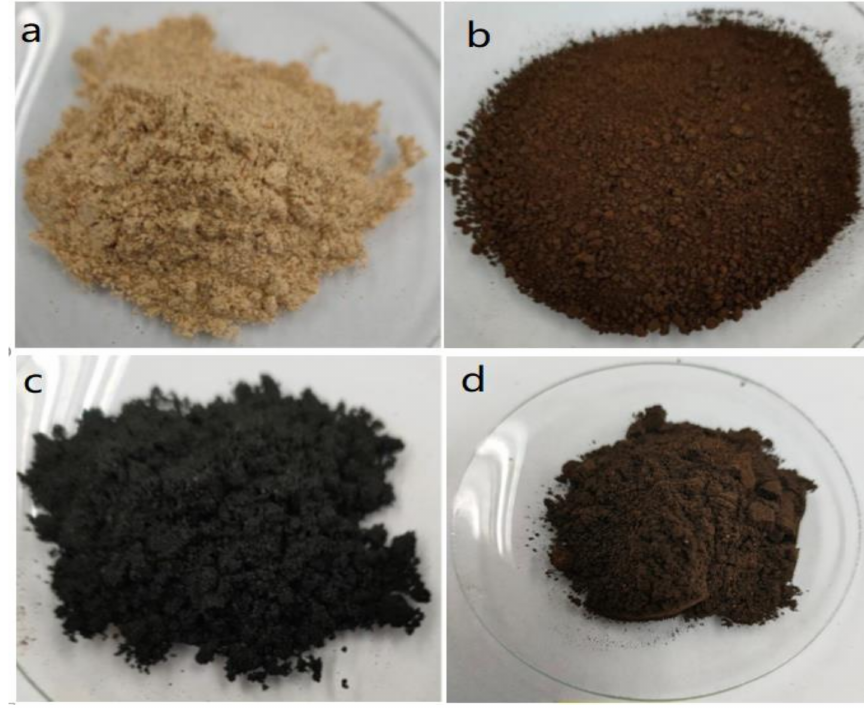
Figure 4. Photographic images for ( a ) Feedstock, ( b ) HTC180, ( c ) PY500, and ( d )